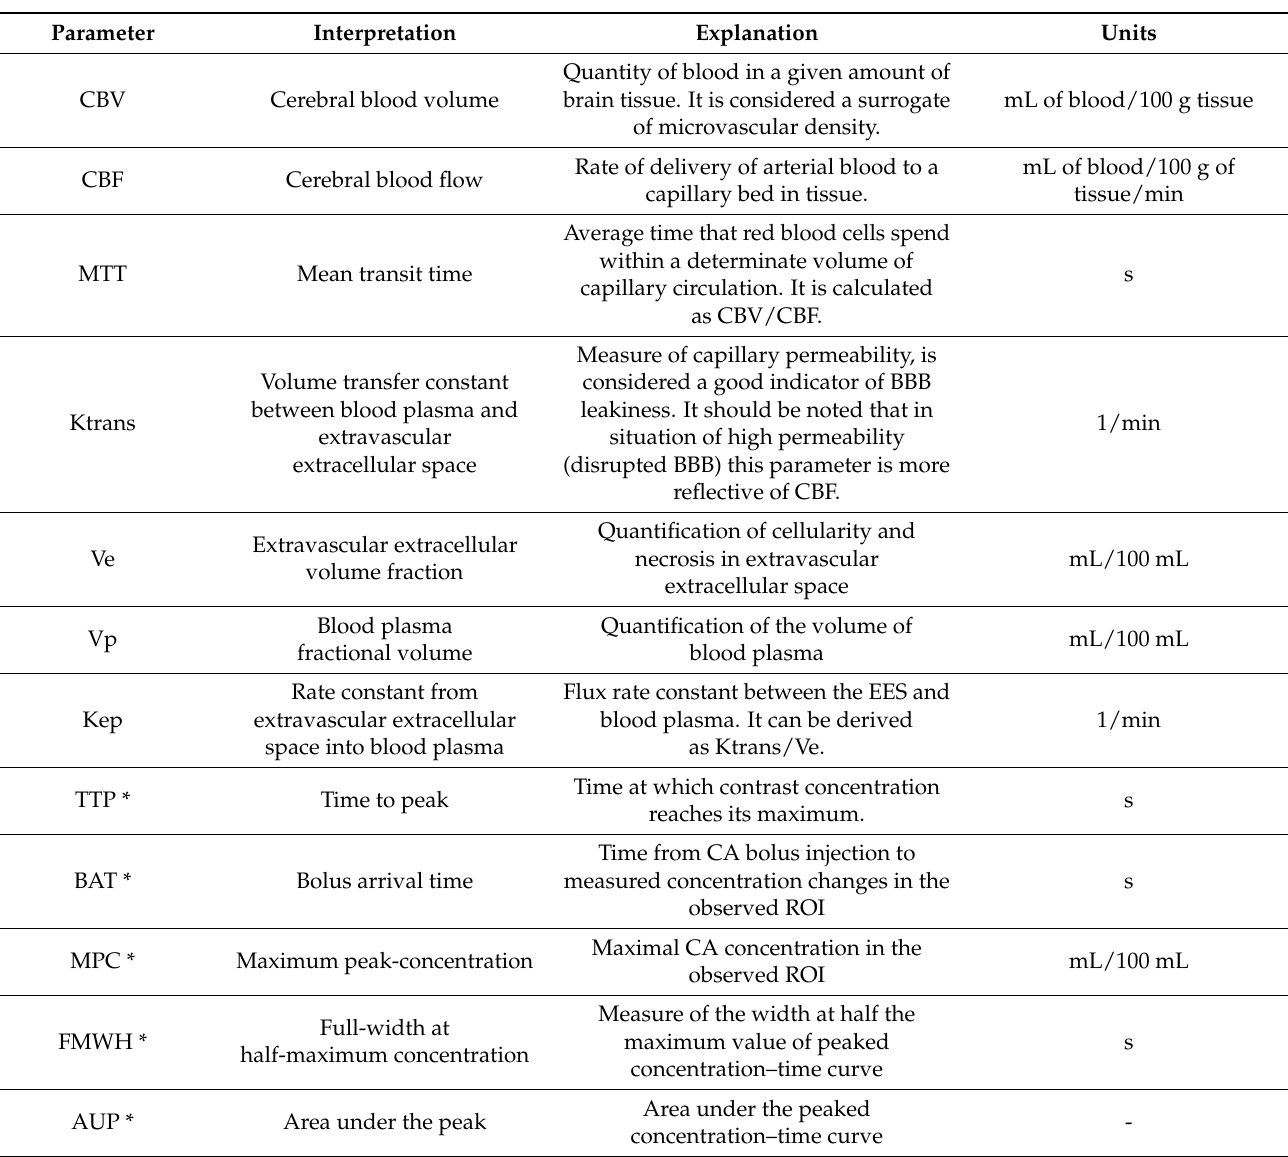
Table 2. Perfusion parameters. Abbreviations: BBB, blood-brain barrier; CA, contrast agent; EES, extravascular extracellular space; g, grams; min, minute; mL, milliliter; ROI, region of interest; s,